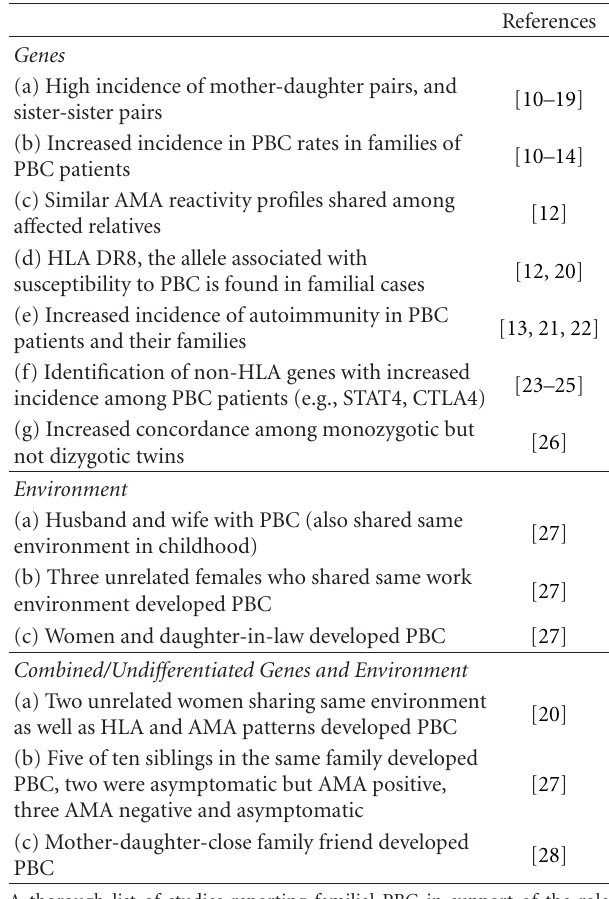
Table 1: Some clues for the aetiopathogenesis of primary biliary cirrhosis (PBC) are provided by family